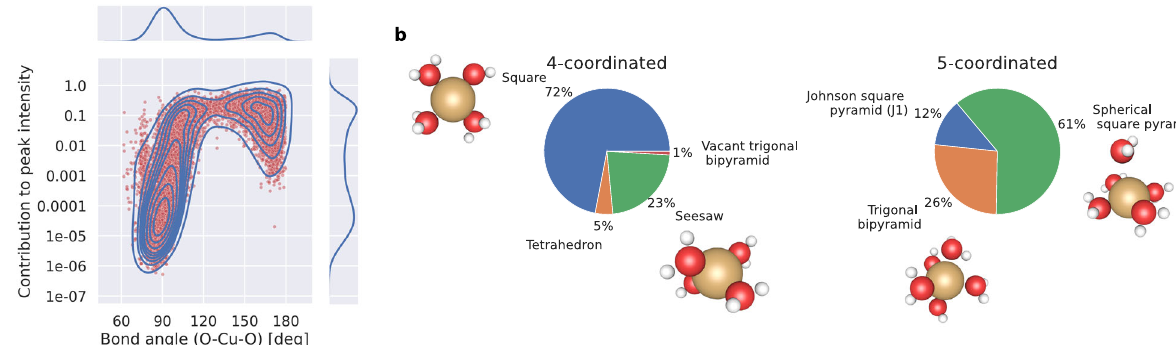
Fig. 8 The Cu(II) aqua complexes that temporarily adopt new, uncommon symmetries may be critical contributors to the optical absorption in the infrared region. This is supported by a the relationship between O-Cu-O bond angles explored by the aqua complex during AIMD and their contributions to the peak intensity; and b the distribution of closest-matching reference geometries based on the minimum CSM value, with AIMD snapshots illustrating the most commonly explored complexes. For this analysis, only fourfold- and fi vefold- coordinated complexes are